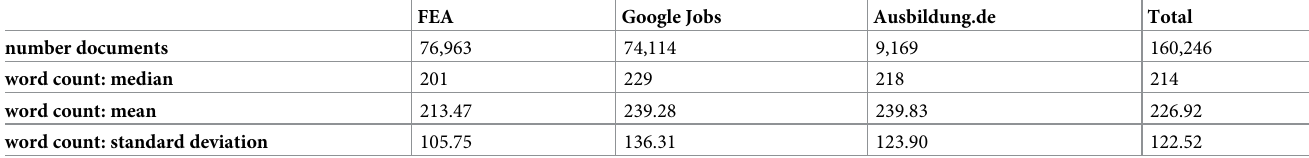
Table 2. Overview of the corpus, where ‘word’ refers to a token created by splitting at white space and selected special characters.